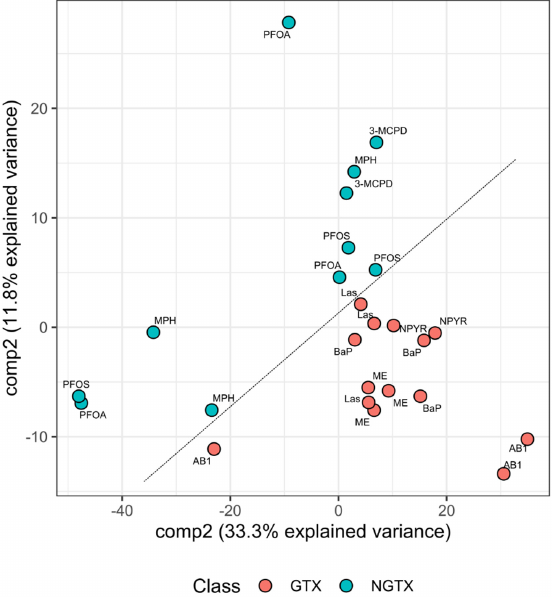
Figure 6. PLS-DA for separation between GTX and NGTX. To improve the separation of GTX and NGTX compounds based on TK6 RNA sequencing data with genotoxins AB1, BaP, Las, ME, or NPYR or with non-genotoxins 3-MCPD, MPH, PFOA, or PFOS, PLS-DA was conducted as an additional bioinformatics approach. For PLS-DA, R package mixOmics version 6.14.1, leave-one-out cross-validation was performed to evaluate the modeling performance, resulting in a BER of 0.35 for component 1 and averaged AUC of 0.59. A clear separation between GTX and NGTX treatments is visible and highlighted by a line. GTX compounds are depicted in red and NGTX in blue.